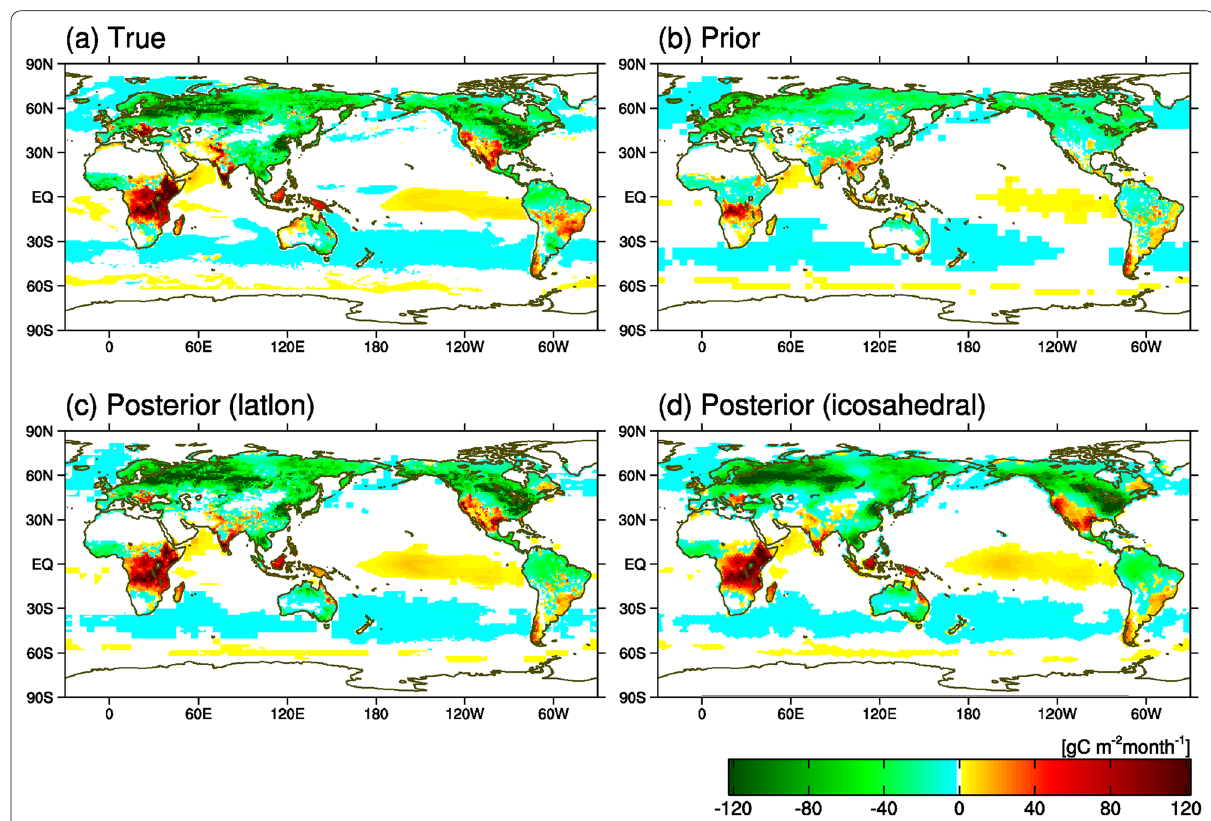
Fig. 6 Distributions of CO 2 fluxes averaged for July 2011 from the true ( a ) and prior ( b ) flux datasets and the posterior fluxes of the CTL ( c ) and ICO ( d ) cases. White color areas depict fluxes close to zero. Fossil fuel emissions, which were not optimized, were